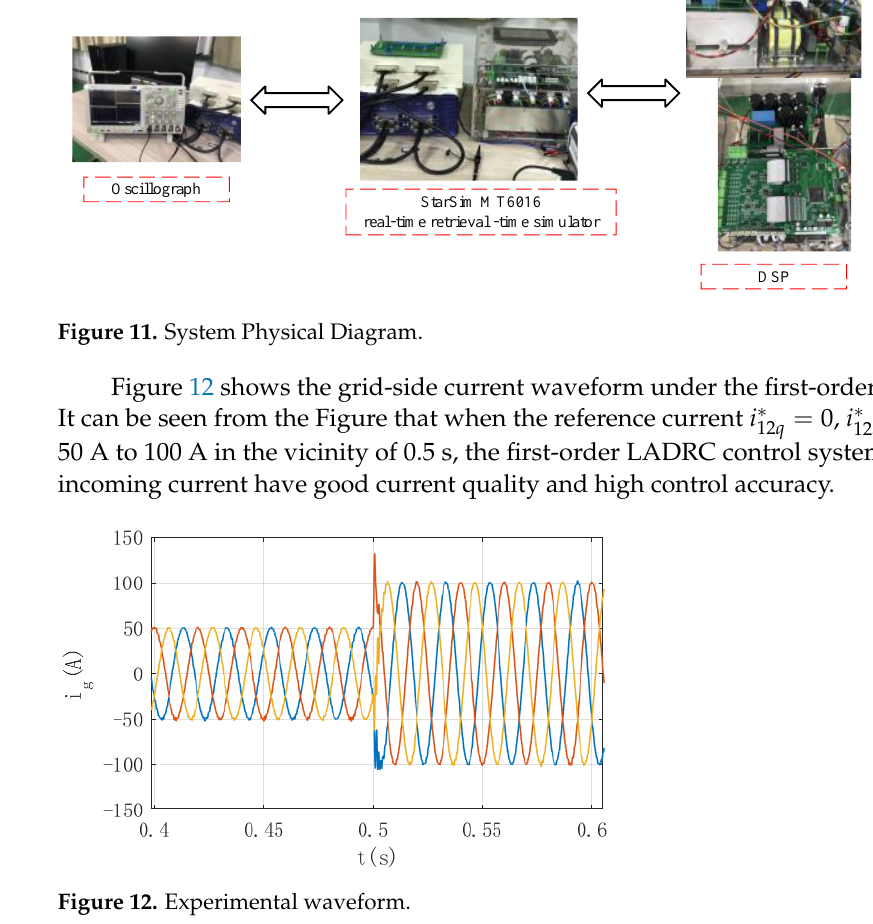
Figure 12. Experimental waveform.